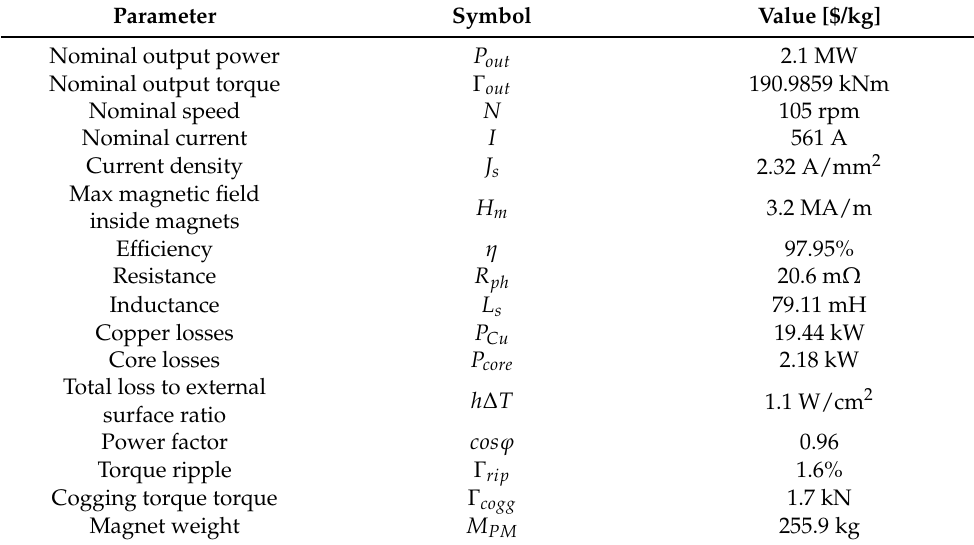
Table 8. Performance of the optimized AFPM